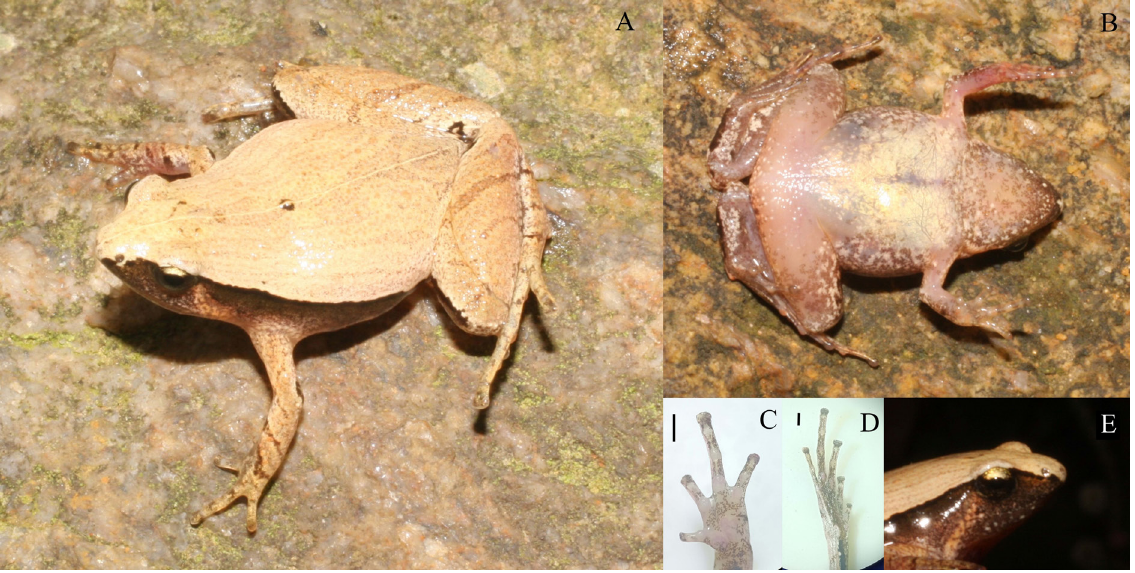
Fig. 4. Microhyla hmongorum sp. nov., ♂, holotype (IEBR A.4905 (TD-LC2020.121)). A . Dorsolateral view in life. B . Ventral view in life. C . Underside of left hand. D . Underside of right foot. E . Lateral view of the head. Scale bars = 1